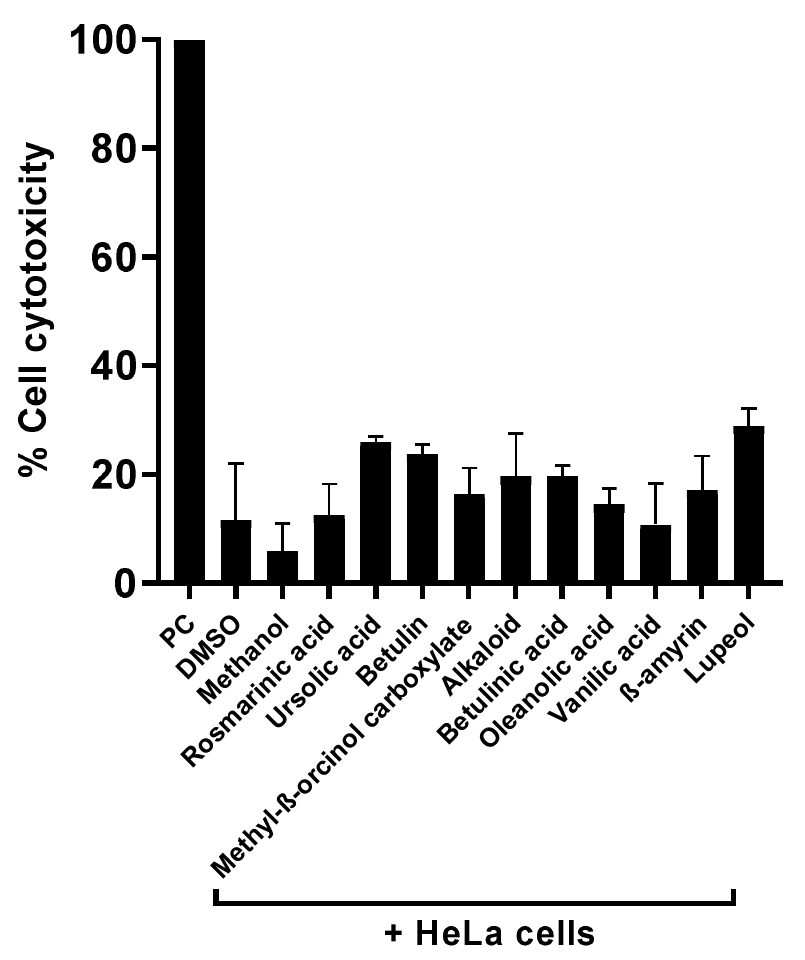
Figure 5. Compounds isolated presented higher cell viability effects against human cell lines. Notably, all compounds showed negligible cytotoxic effects against HeLa cell lines.